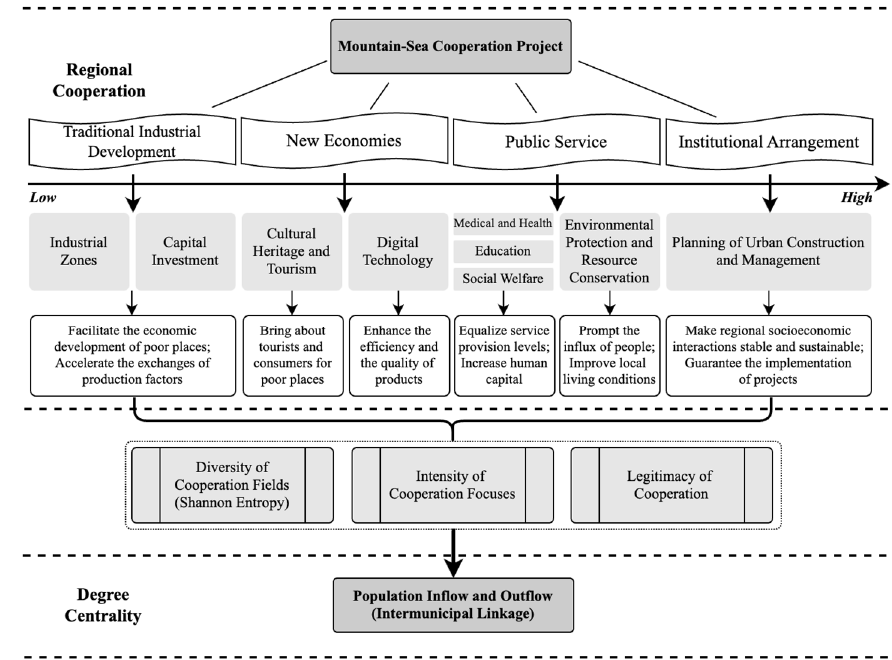
Figure 1. The conceptual framework.